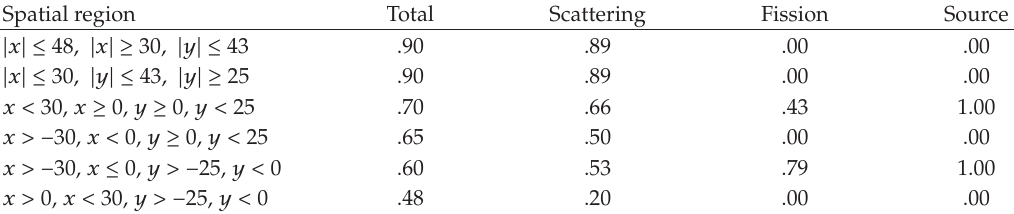
Table 2: Cross sections and sources values for EIR